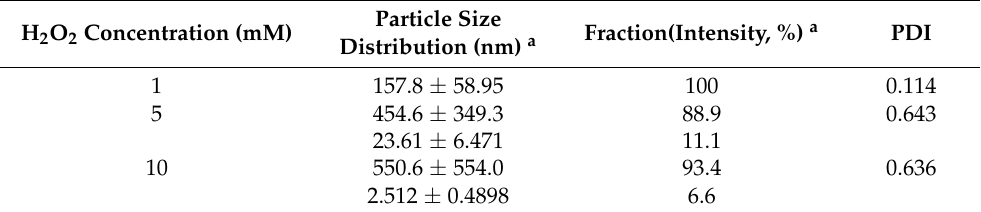
Figure 3. The effect of H 2 O 2 concentration on the changes in particle size distribution ( a – c ), and TEM images ( d – f ) of HAthCe6 nanophotosensitizers: ( a , d ), 1.0 mM H 2 O 2 ; ( b , e ), 5.0 mM H 2 O 2 ; ( c , f ), 10 mM H 2 O 2 . Table 2. Effect of H 2 O 2